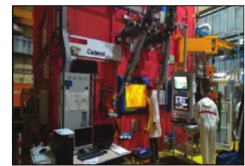
Fig. 5. The Cadecol shielded cell. Fig. 6. Fission chamber.